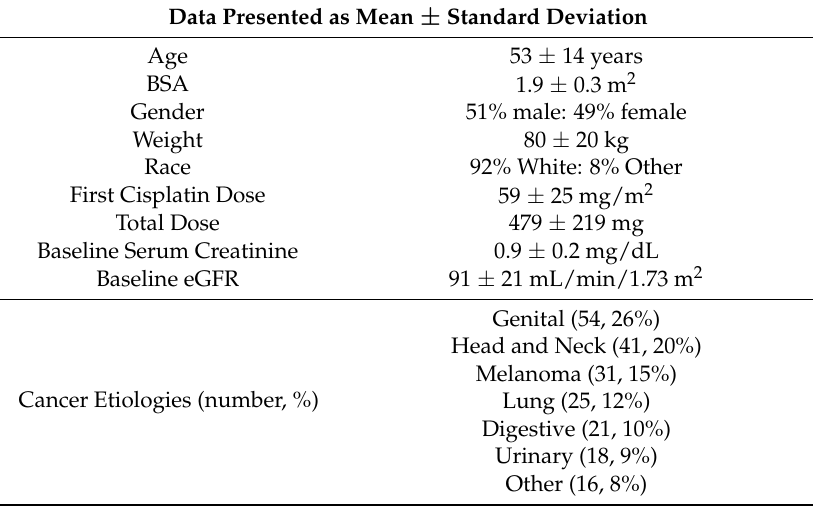
Table 1. Patient Characteristics ( n =